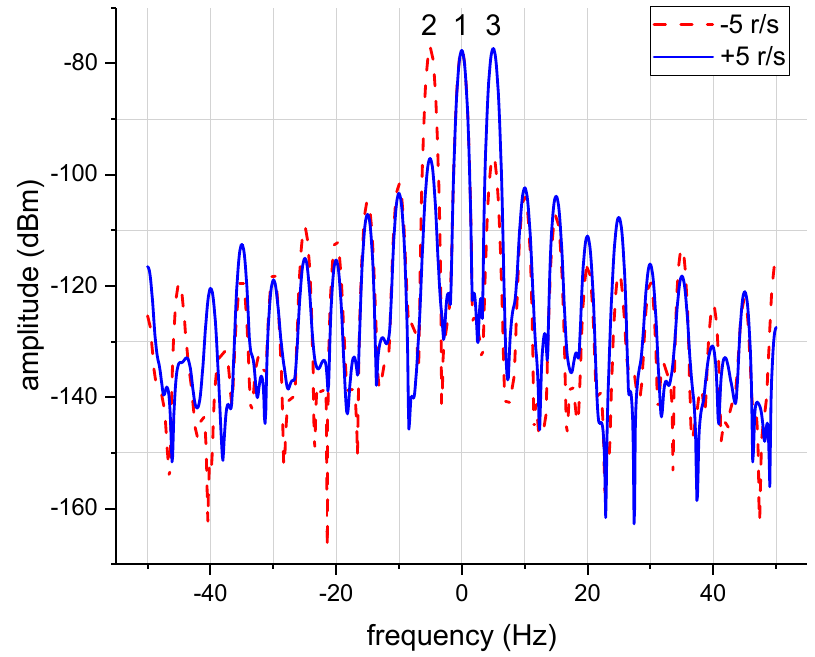
Figure 9. The frequency spectrums of the received signals for the rotation speed is − 5 r/s (dash red), and the rotation speed is +5 r/s (solid blue).